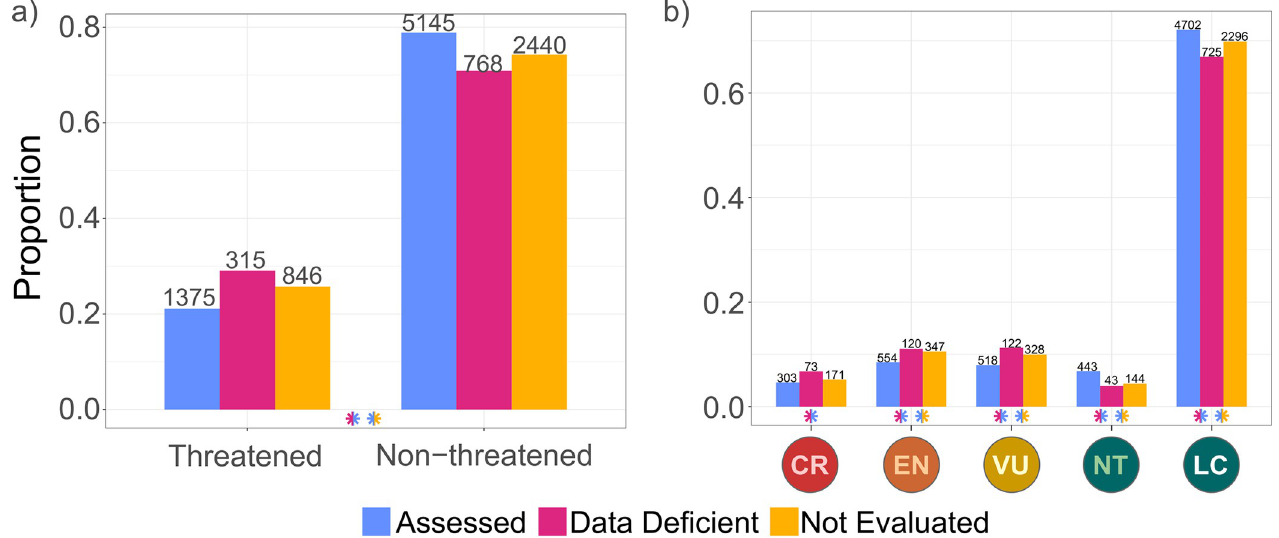
Fig 1. Proportion of reptile species assigned to extinction risk categories by IUCN manual assessment (assessed) and by an automated assessment model (Data Deficient and Not Evaluated). (A) Grouping categories into threatened and nonthreatened and (B) specific extinction risk categories: CR, Critically Endangered; EN, Endangered; LC, Least Concern; NT, Near Threatened; VU, Vulnerable. Number of species in each category is indicated above each bar. Significant differences in a Pearson’s χ 2 test are indicated by asterisks, colored according to which proportions are being compared (S7 Table). The data underlying this figure can be found in S2